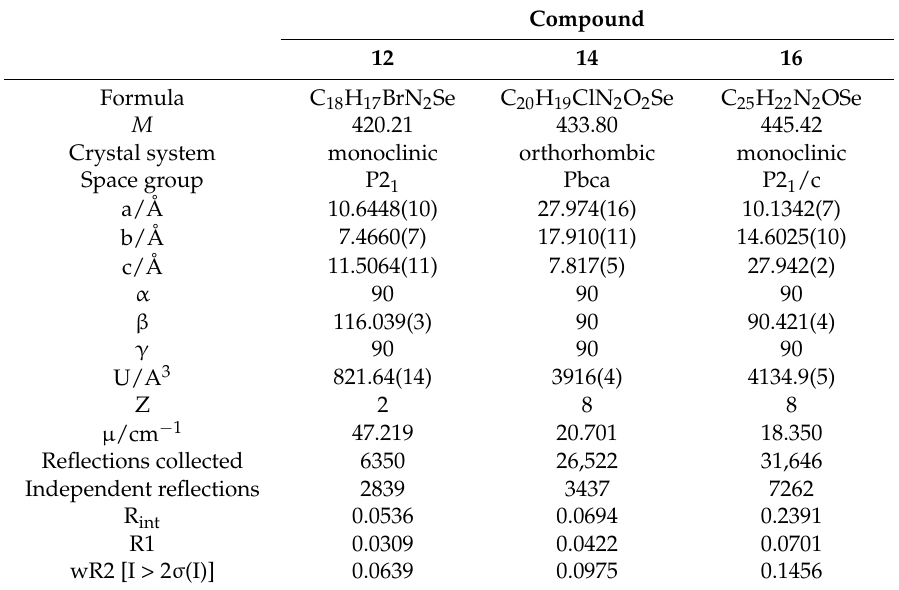
Table 3. Details of the X-ray Data Collections and Refinements for Compounds 12 , 14 and 16